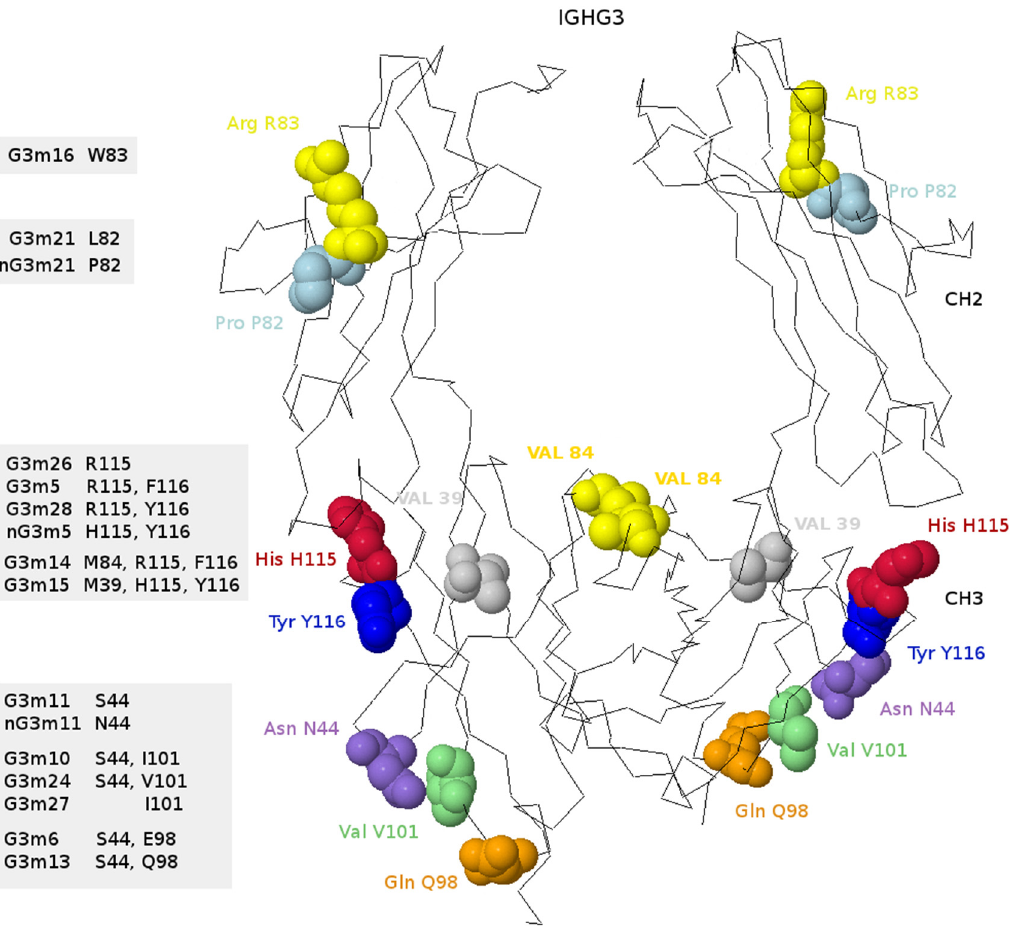
Figure 40. G3m allotypes localizations on the gamma3 chains [83]. (With permission from M-P. Lefranc and G. Lefranc, LIGM, Founders and Authors of IMGT ® , the international ImMunoGeneTics information system ® , http://www.imgt.org).